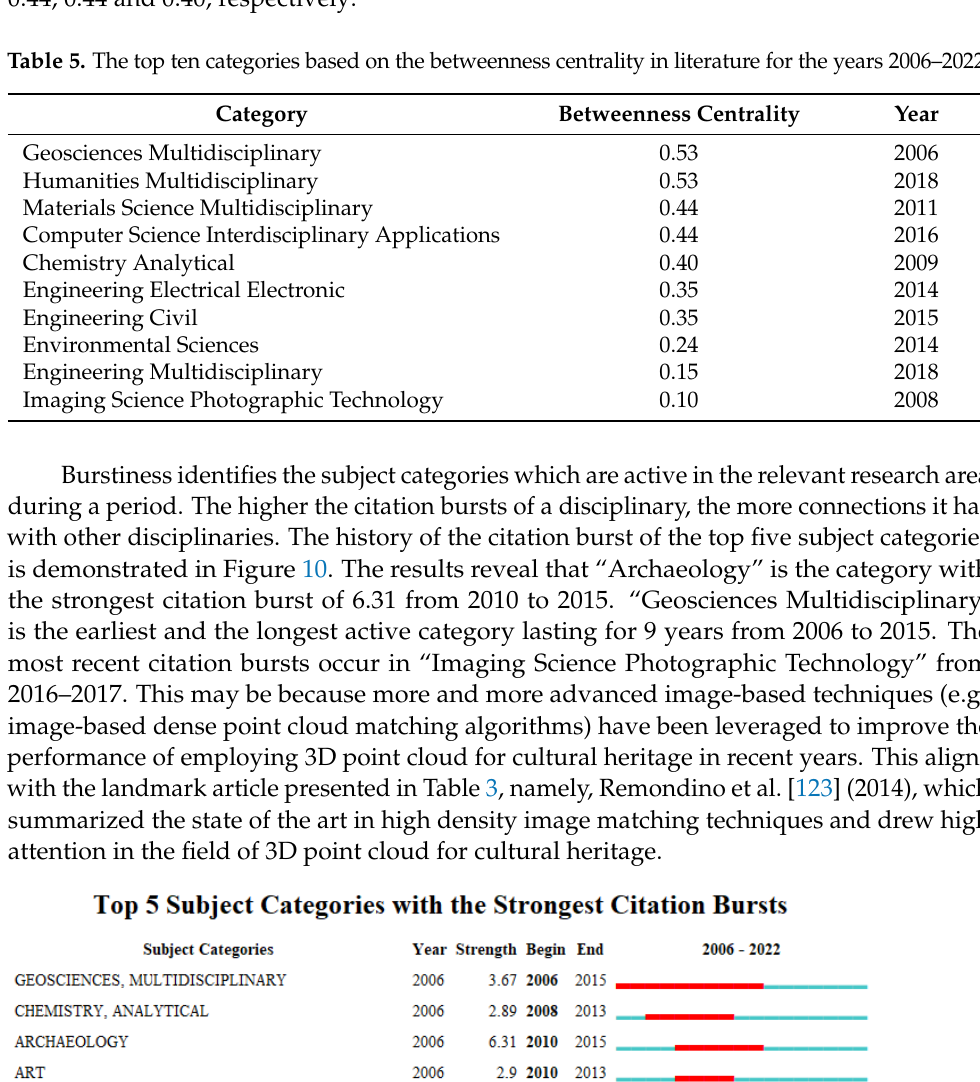
Table 5. The top ten categories based on the betweenness centrality in literature for the years 2006- 2022.